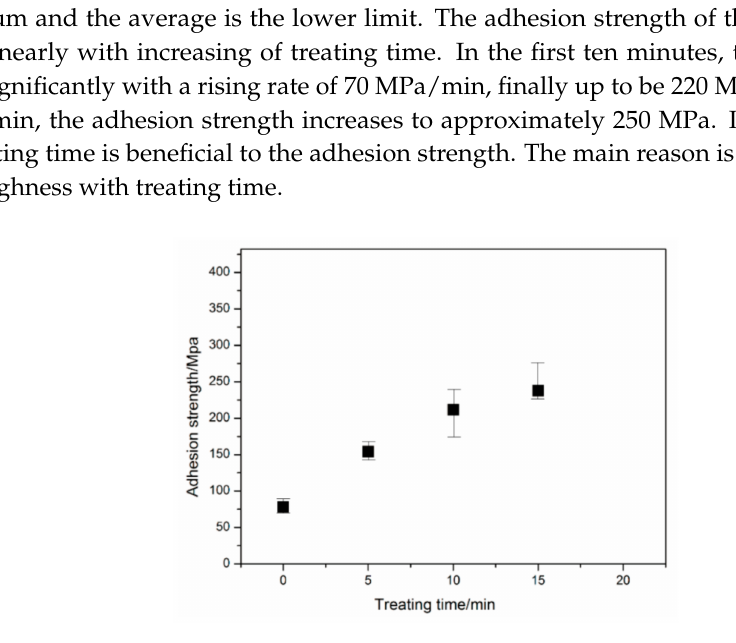
Figure 1. The adhesion strength of the Ni films treated by 5 vol % hydrochloric